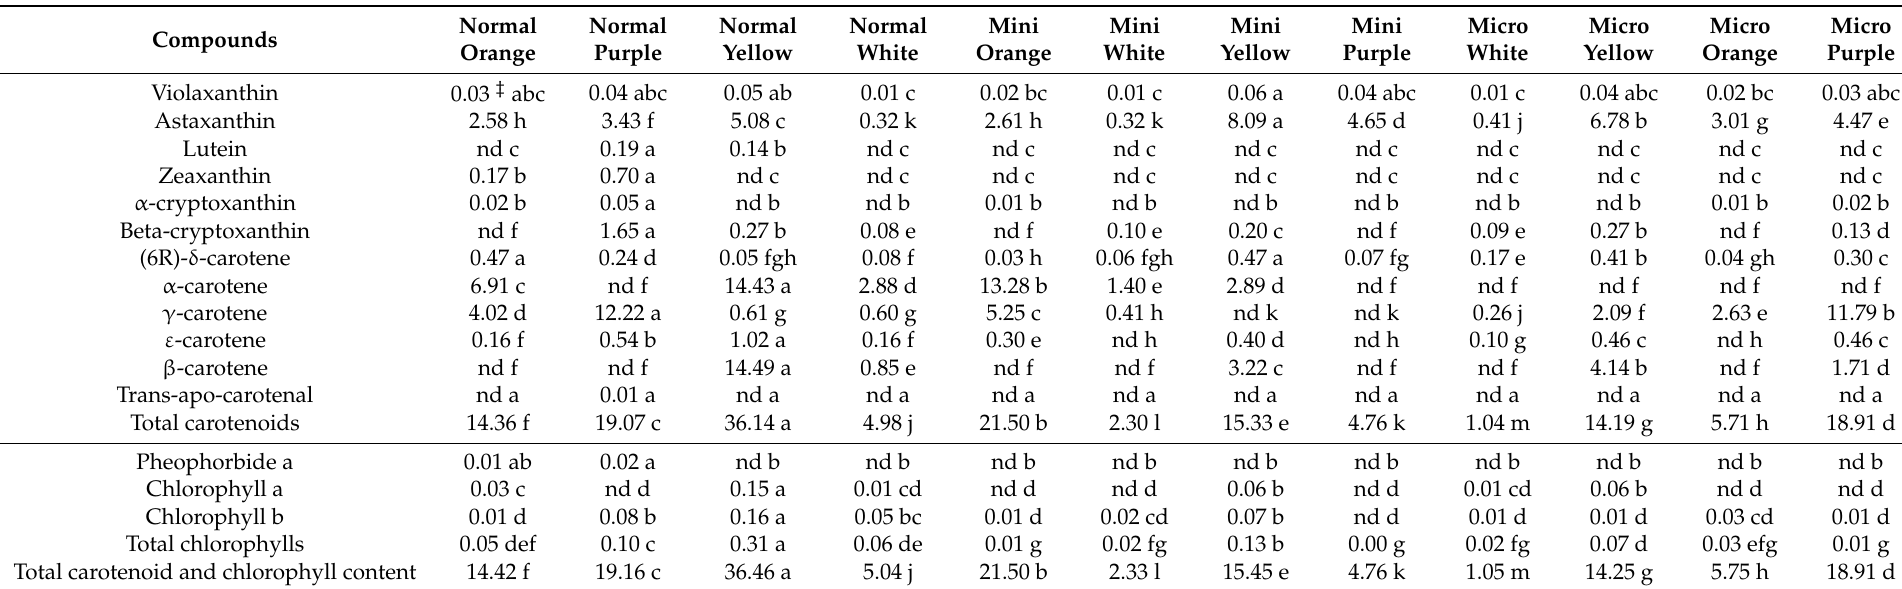
Table 3. Quantifications of carotenoids and chlorophylls of 12 carrot